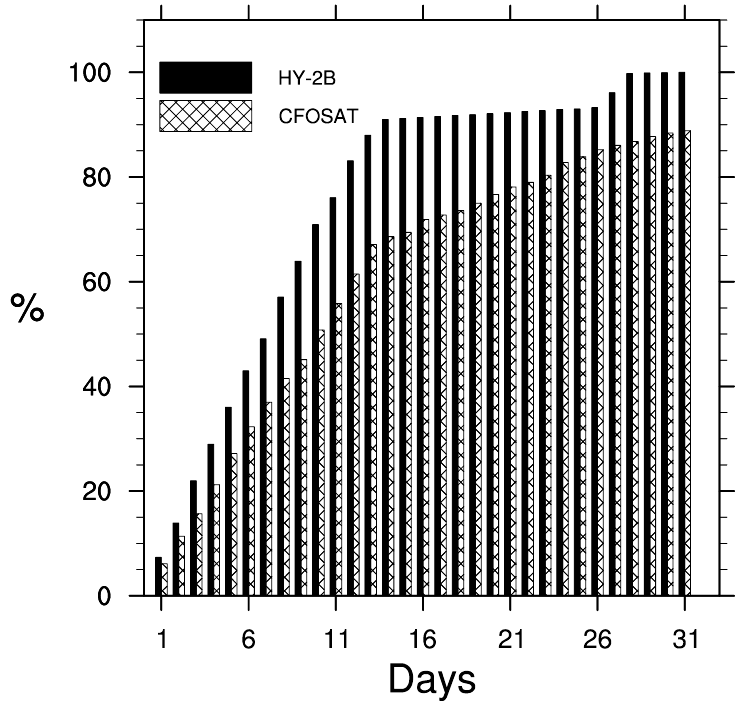
Figure 6. The coverage variance according to the number of days. The solid, filled bars indicate the coverage of HY − 2B over East Asia, while the cross − hatched bars denote the coverage variance of CFOSAT according to the number of days. The 31 − day cumulative box of HY − 2B is set as 100%.